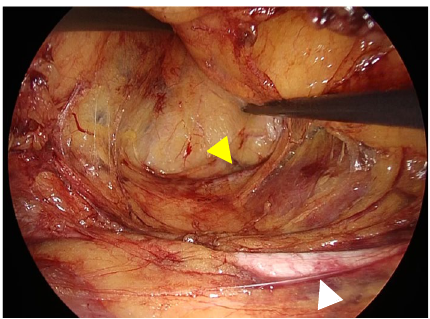
Fig. 4 The relationship between the left ureter and left gonadal vessels. The left gonadal vessels ran lateral to the left ureter in mobilizing the descending and sigmoid colons via a medial approach. The left ureter (white arrowhead) and left gonadal vessels (yellow arrowhead) are shown